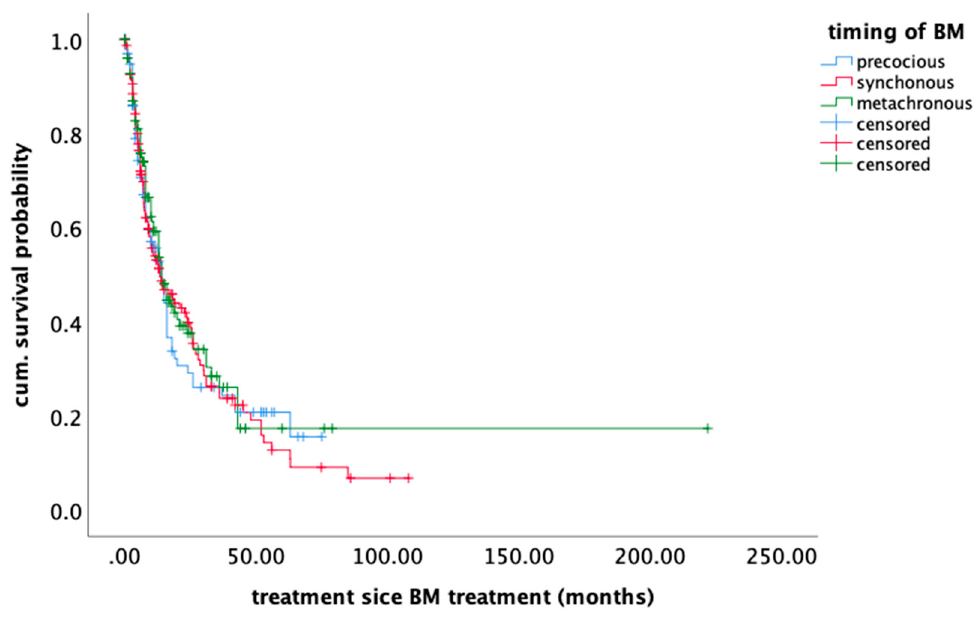
Figure 1. Kaplan–Meier plot showing overall survival of patients bearing brain metastases depending on the time of appearance. Table 2. Analysis of prognostic factors in uni- and multivariate analysis.